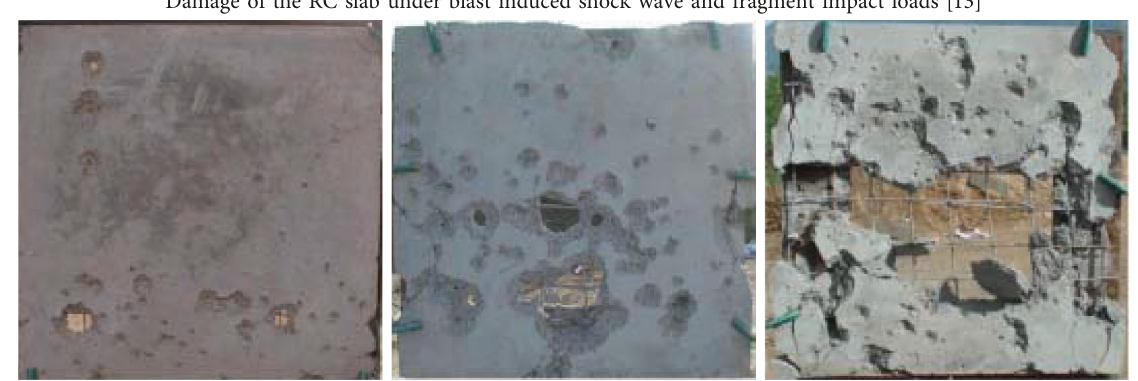
Table 6: Summary of experimentally tested damage on reinforced concrete slab subjected to combined blast and impact